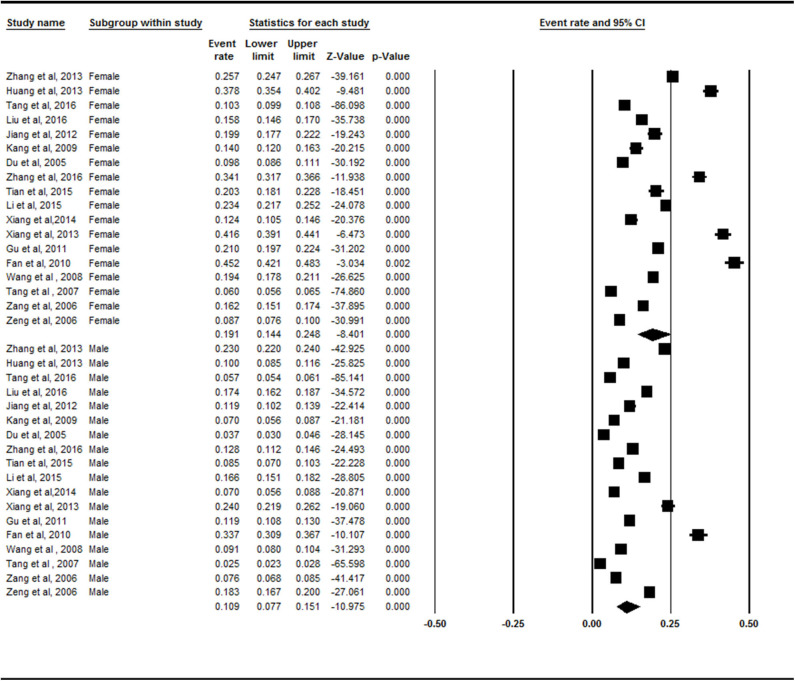
Forest plot of the prevalence rates of symptomatic knee osteoarthritis by sex. CI, confidence interval. A total of 18 studies investigated the different prevalence of symptomatic knee osteoarthritis in both sexes. Females (19.1%, 95% CI = 14.4–24.8) exhibited a higher prevalence of symptomatic knee osteoarthritis than males (10.9%, 95% CI = 7.7–15.1%) in the subgroup analysis.